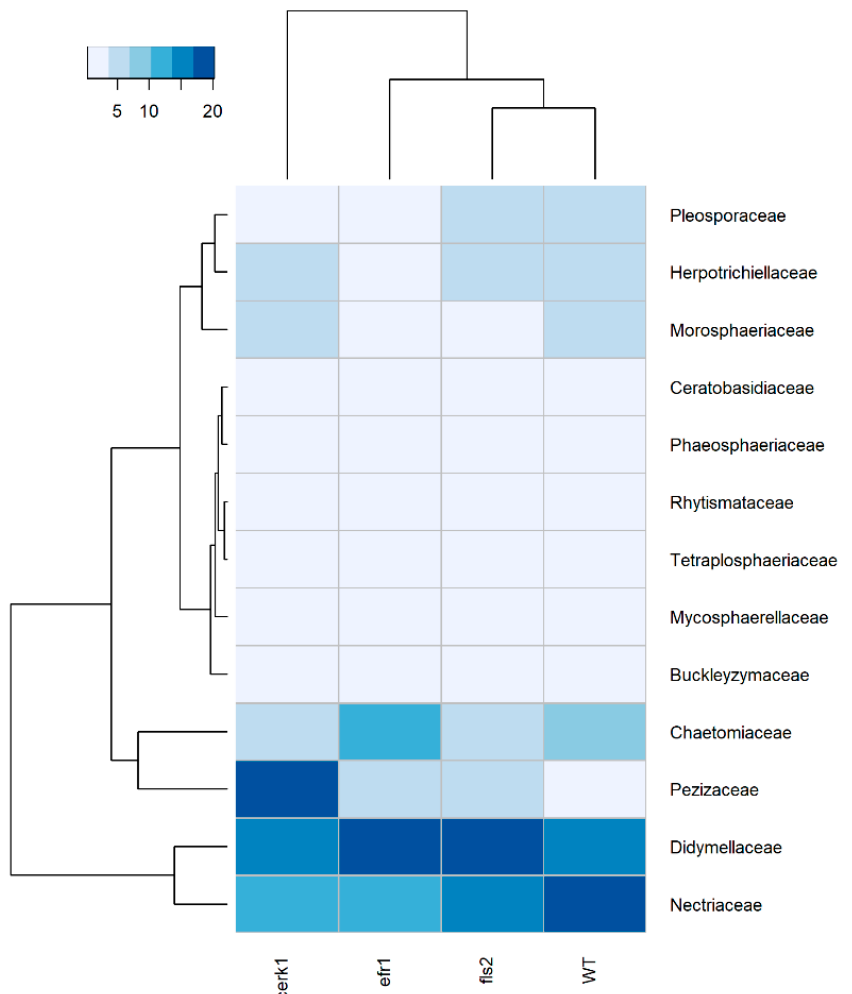
Figure 4. Heatmap displaying fungi relative abundance at the family level from the rhizosphere of Arabidopsis PAMP mutants ( cerk1 , efr1 , and fls2 ) and the wild-type (WT; Col-0) grown in native soil from the Red River Farm (OK, USA). Heatmap is color-coded based on relative abundance values. Less enriched samples are shown in light blue/grey while dark blue represents highly enriched samples. Samples with similar microbial profiles were recursively grouped together in branches of a dendrogram at the top. Families with <1% abundance were not included. Hierarchical clustering of distances using taxonomy relative abundance data were generated using Euclidean distance calculation to obtain a matrix and dendrogram construction using R. The diversity of microbial community in the rhizosphere can be analyzed by looking at the α -diversity and β -diversity. Alpha-diversity is the observed species richness or taxa number of a given sample as well as their relative abundance. Beta-diversity on the other hand is the variability in community composition or how dissimilar two communities can be [16]. Alpha-diversity measurements based on Faith’s phylogenetic diversity for bacterial rhizosphere samples (Figure 5) indicated that bacterial diversity did not vary significantly between genotypes ( p -value < 0.05) (Table